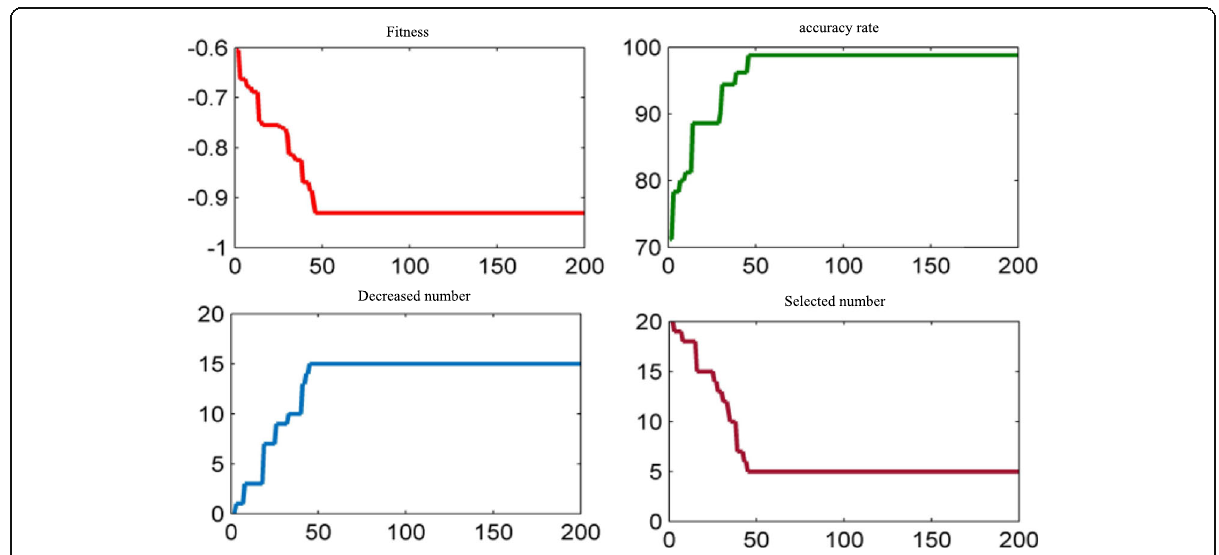
Fig. 4 The curve of convergence for feature